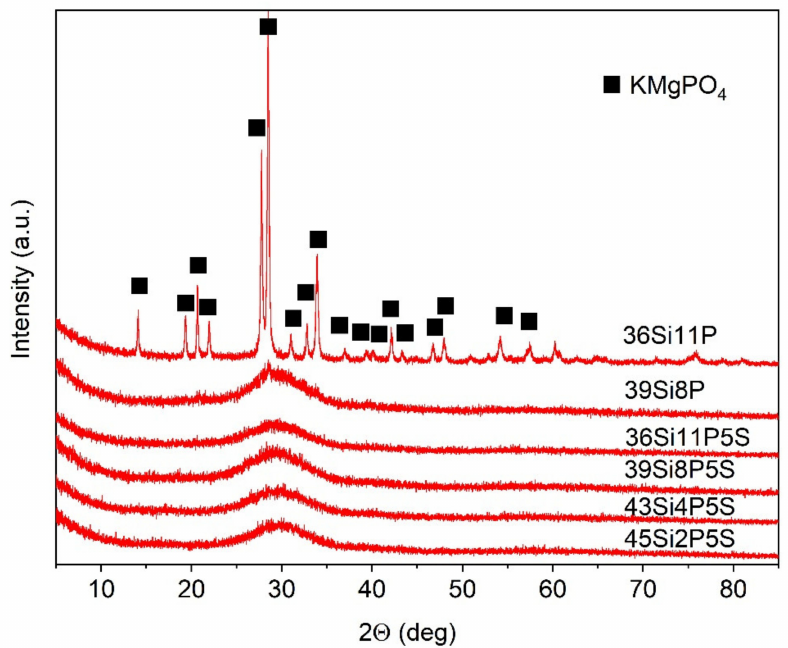
Figure 1. XRD patterns of the studied glass